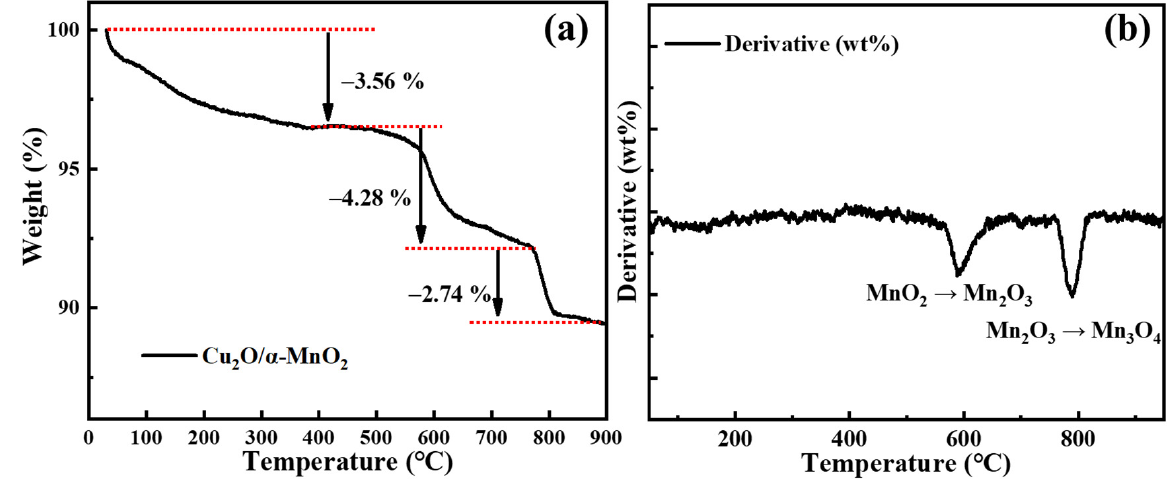
Figure 6. ( a ) TG result and ( b ) the DTG result for the Cu 2 O/ α -MnO 2 in air atmosphere.